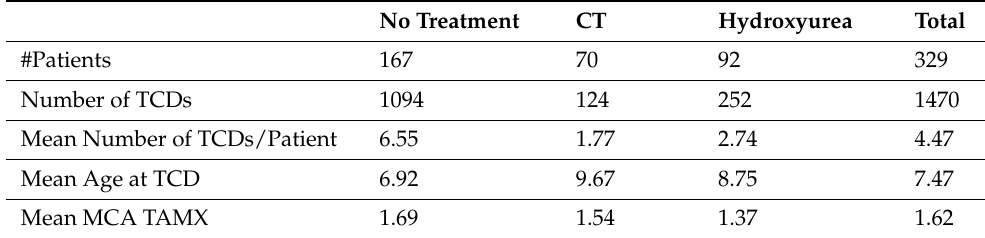
characteristics by treatment level: no treatment, CT, and HU. The 329 unique patients were distributed by no treatment (167), CT (70), and HU (92), with a maximum of ten episodes per patient, or 1094, 124, and 252 episodes, respectively, and totaling 1470 episodes. The average number of episodes per patient is depicted by treatment category and overall average. Each patient’s TCD was measured twice at each episode, doubling the number of TCD measures. We assume that each side (denoted